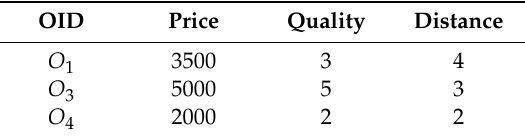
Table 2. Candidate filtering object group of P 1